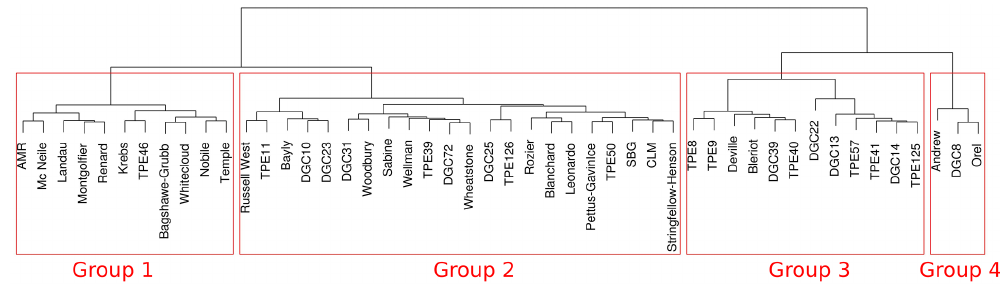
Figure 6. Dendrogram of hierarchical cluster analysis of glaciers in sector West. The glaciers are assorted in four groups (red rectangles). See also Sect. 5.3.